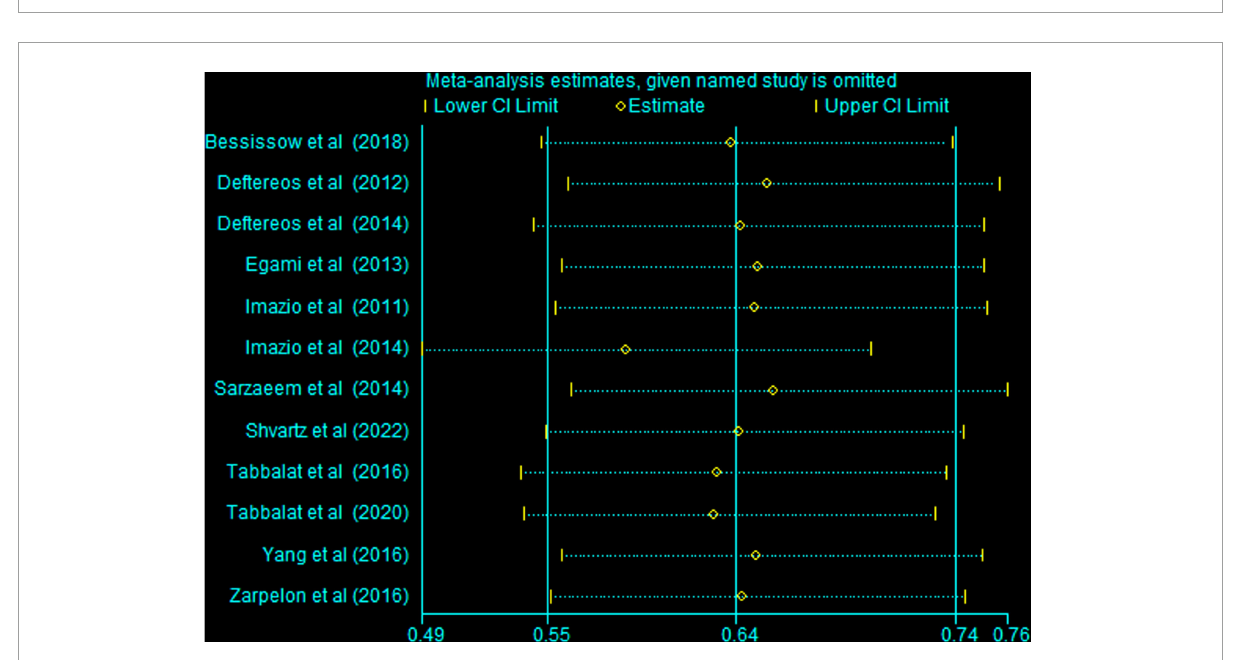
FIGURE6 Egger’s test funnel plots to assess the evidence of publication bias.